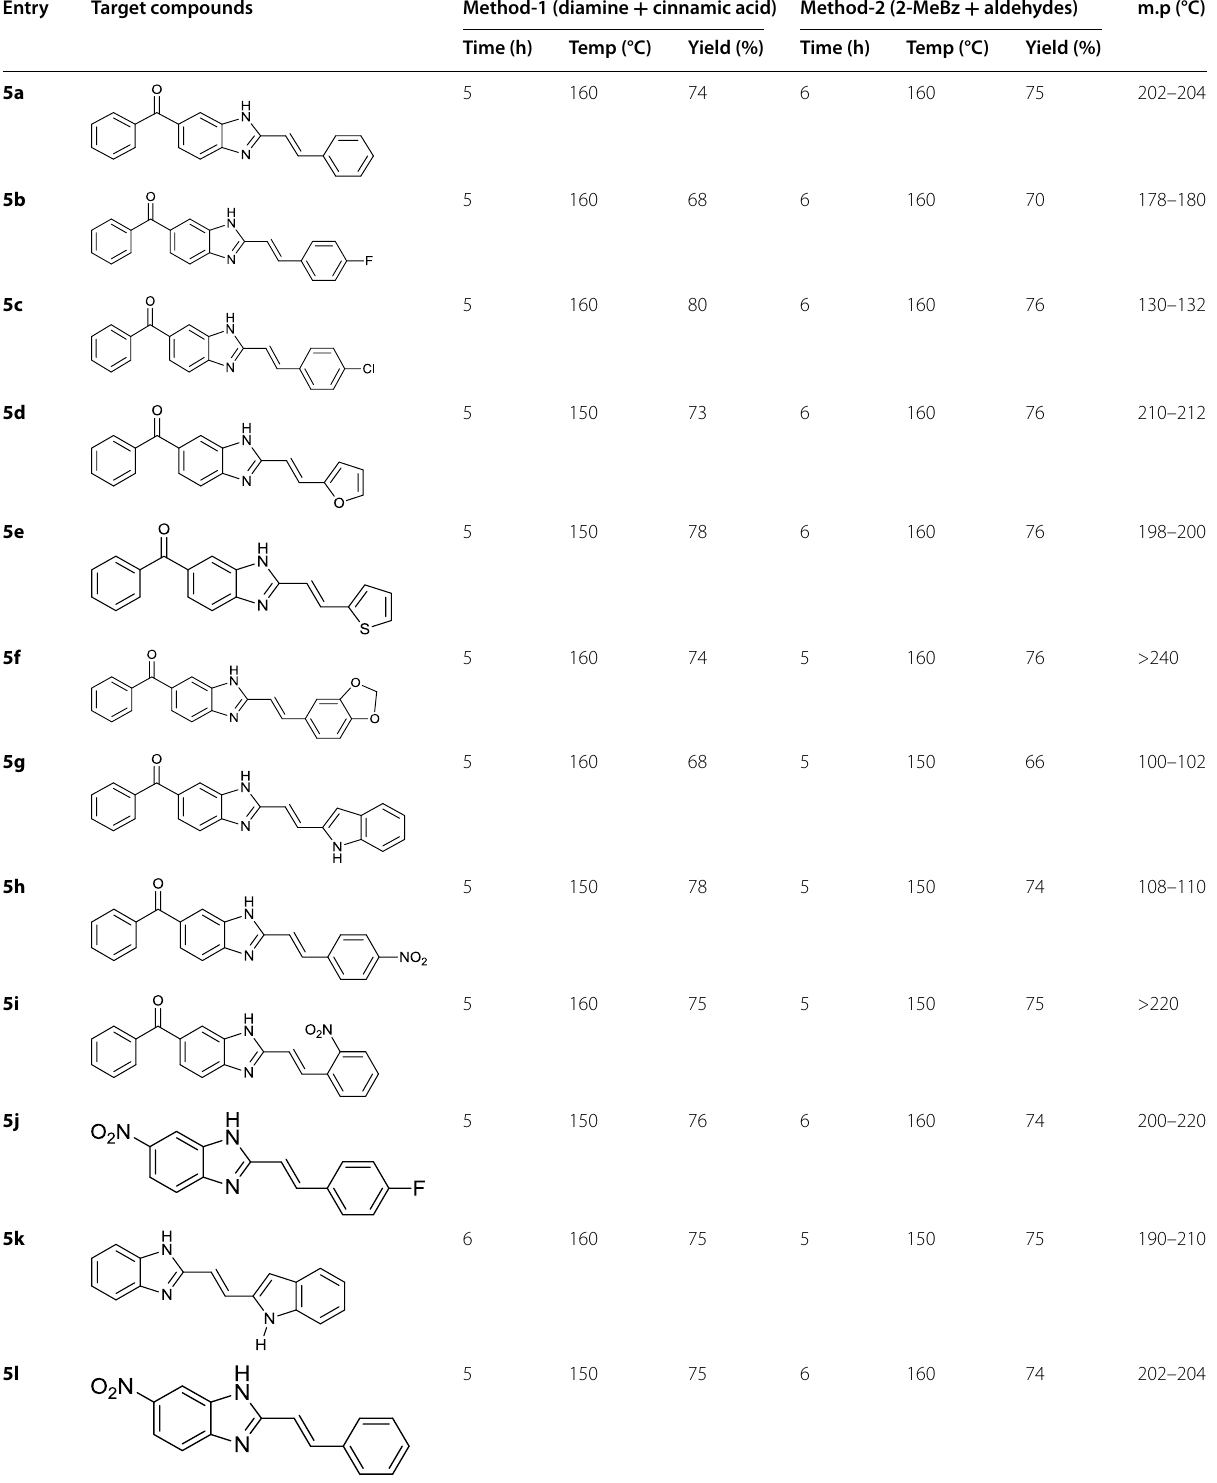
Table 1 Synthesis of target compounds